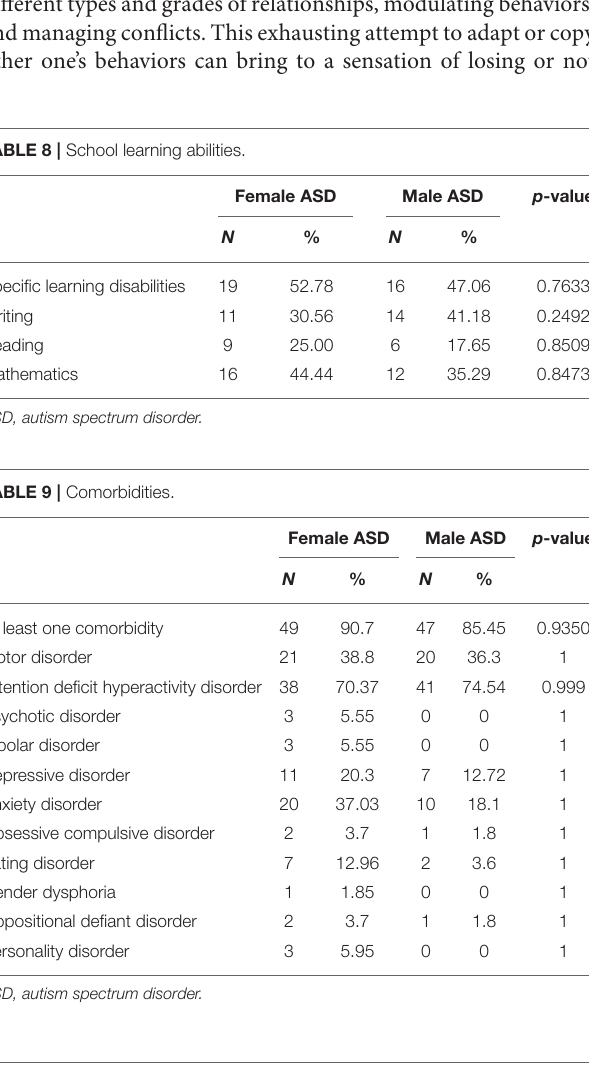
TABLE 7 | Intelligence